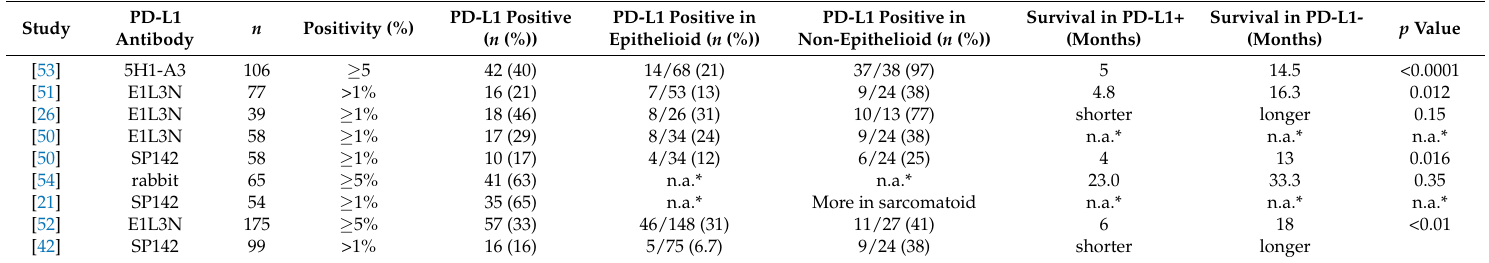
Table 5. PD-L1 expression in